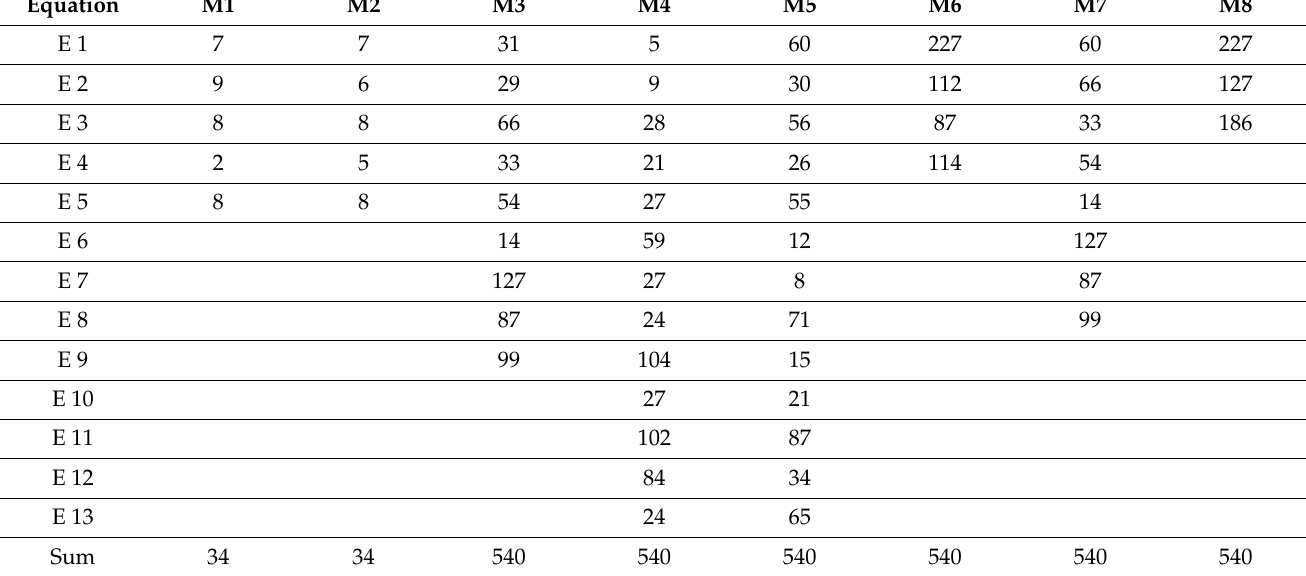
Table 12. Number of calibration data used to develop the models and